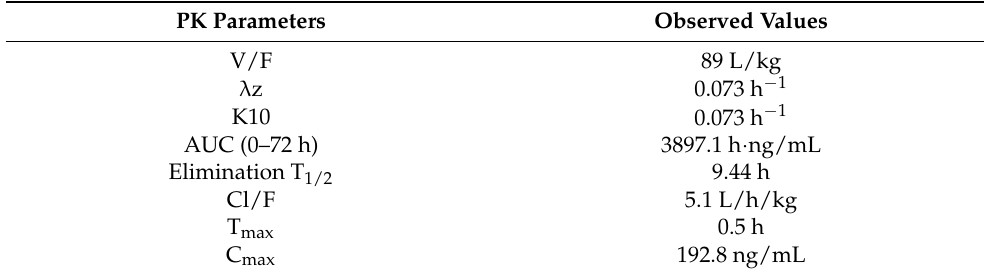
Table 2. The key PK parameters for the plasma concentration-time profile fitted a non-compartment model for RIDR-PI-103.